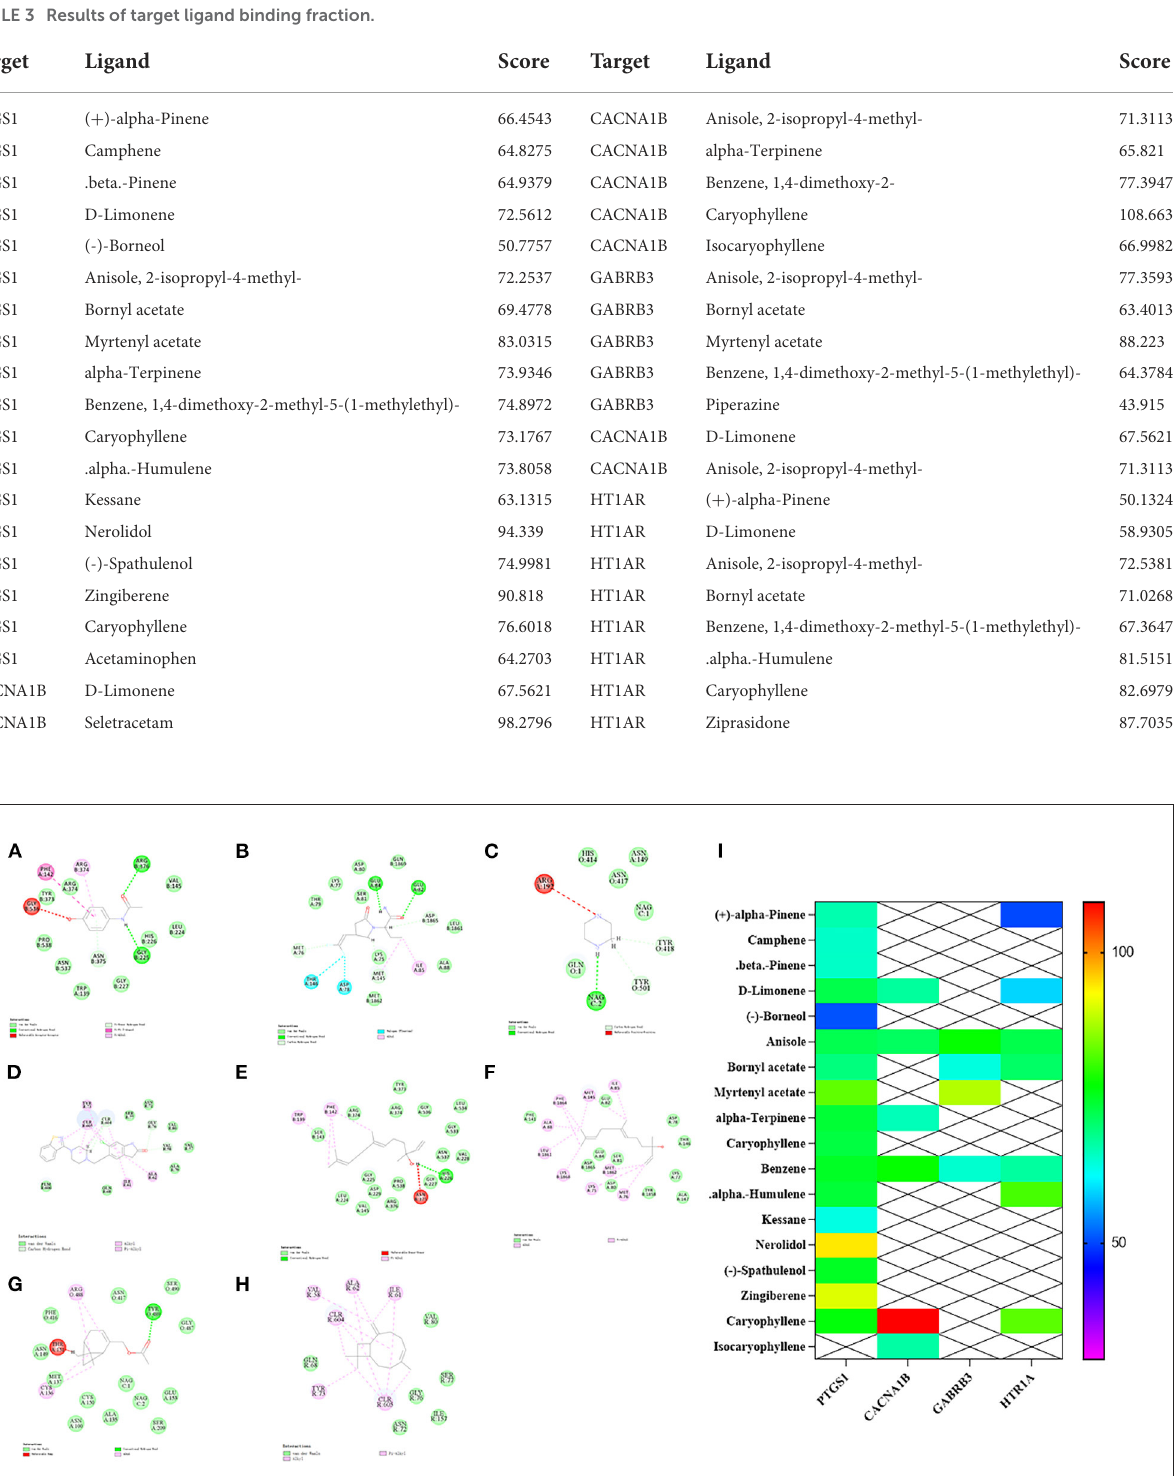
FIGURE5 Molecular docking results and heat map display of target and active ingredient. (A–D) The docking results of PTGS1, CACNA1B, GABRB3 and HT1AR with positive drugs, respectively. (E–H) The docking results of PTGS1, CACNA1B, GABRB3 and HT1AR with nerolidol, caryophyllene, myrtenyl acetate and ziprasidone, respectively. (I) Comprehensive heat map